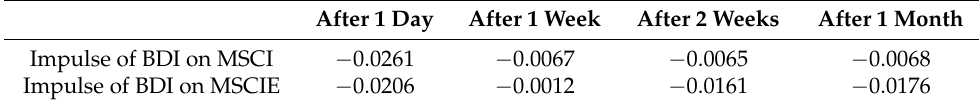
Table 5. Cumulative impulse of BDI on MSCI and MSCIE.